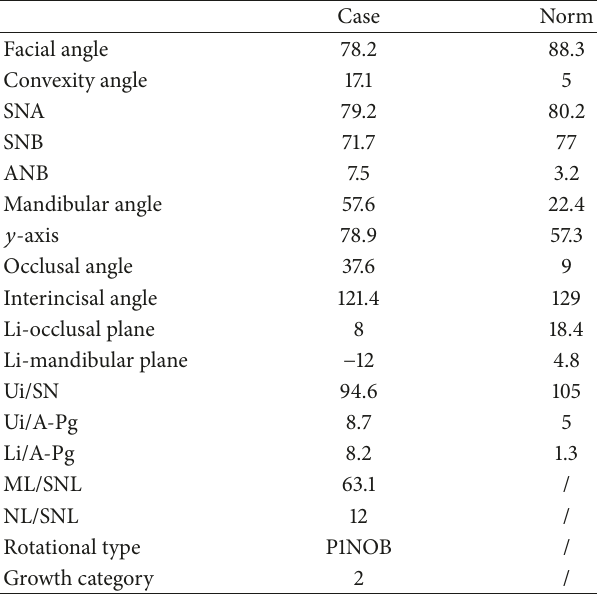
Table 1: Pretreatment cephalometric analysis. Table 2: Arnett-Bergman soft tissues analysis before